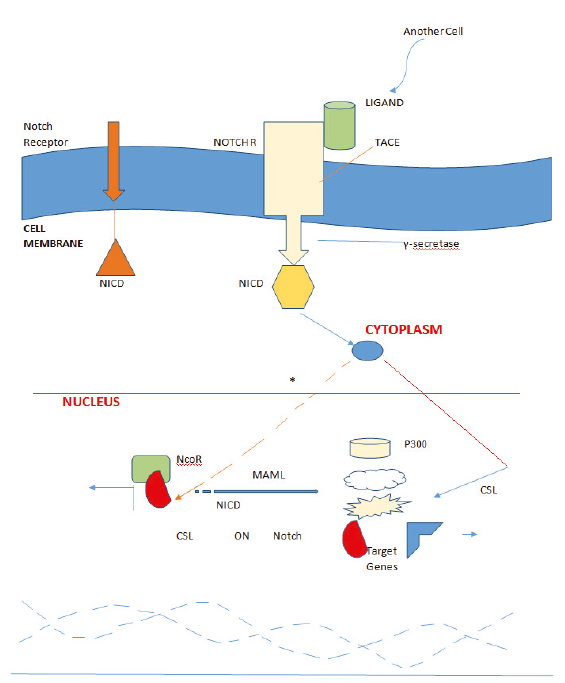
Figure 1: The Notch signaling pathway. * NICD dissociated NcoR from CSL and CSL becomes the activating agent that attracts other complexes (P300,